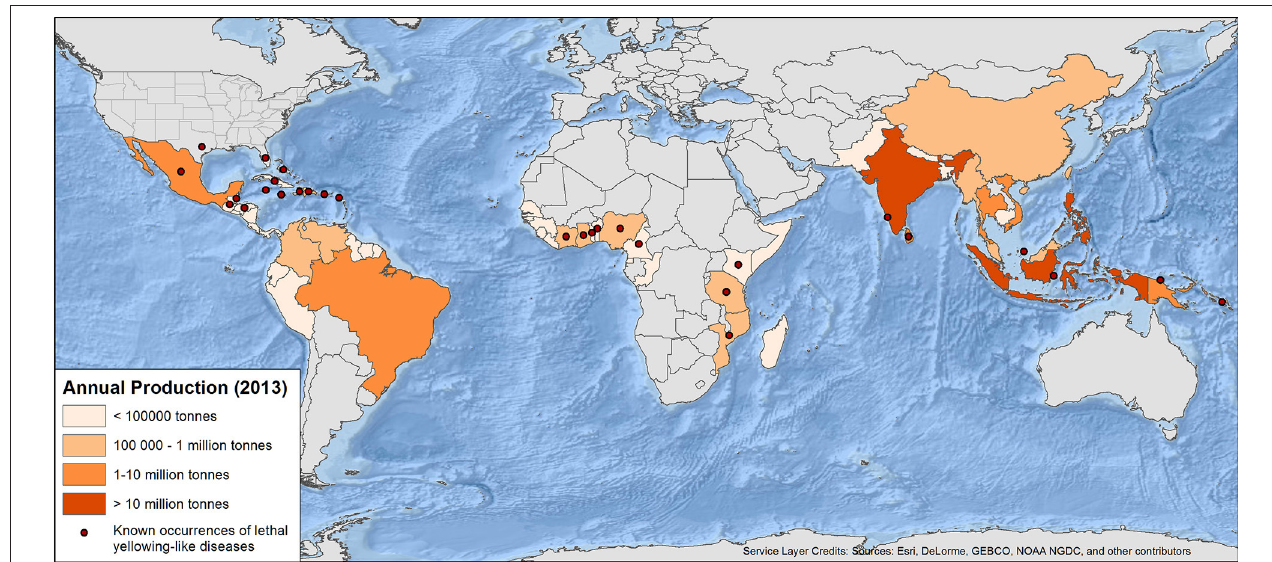
FIGURE 1 | World map of annual coconut production and current published occurrences of lethal yellowing-type diseases of palms (see Table 1 and text for full detail and caveats) production data from FAO